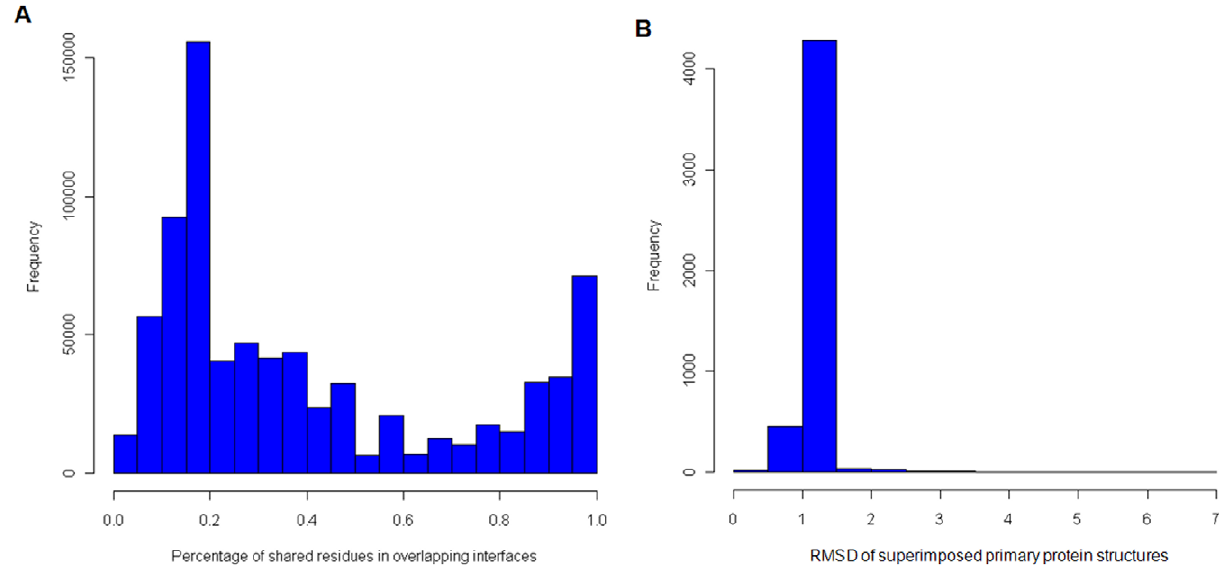
Figure 4. Histogram plots. (A) Percentage of shared residues in overlapping interfaces. (B) RMSD of superimposed primary protein structures.